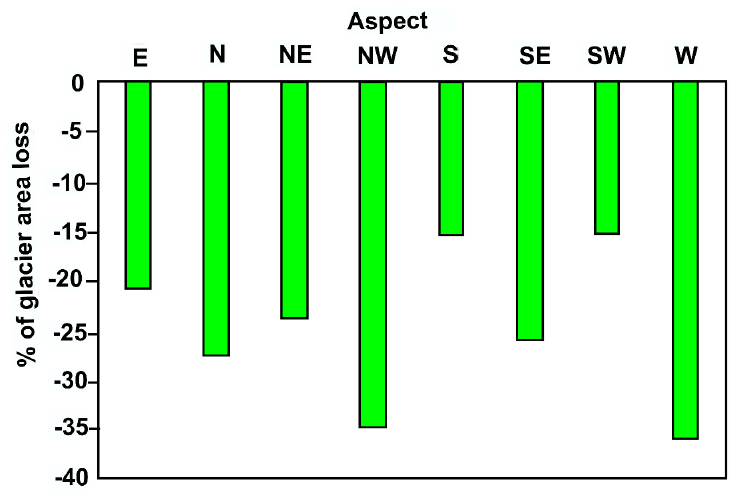
Figure 15. Varying percentage of glacier area loss on different aspects.